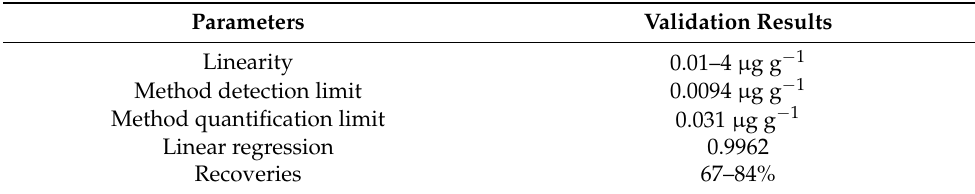
Table 1. Validation data for the detection method of C61-PCBM in